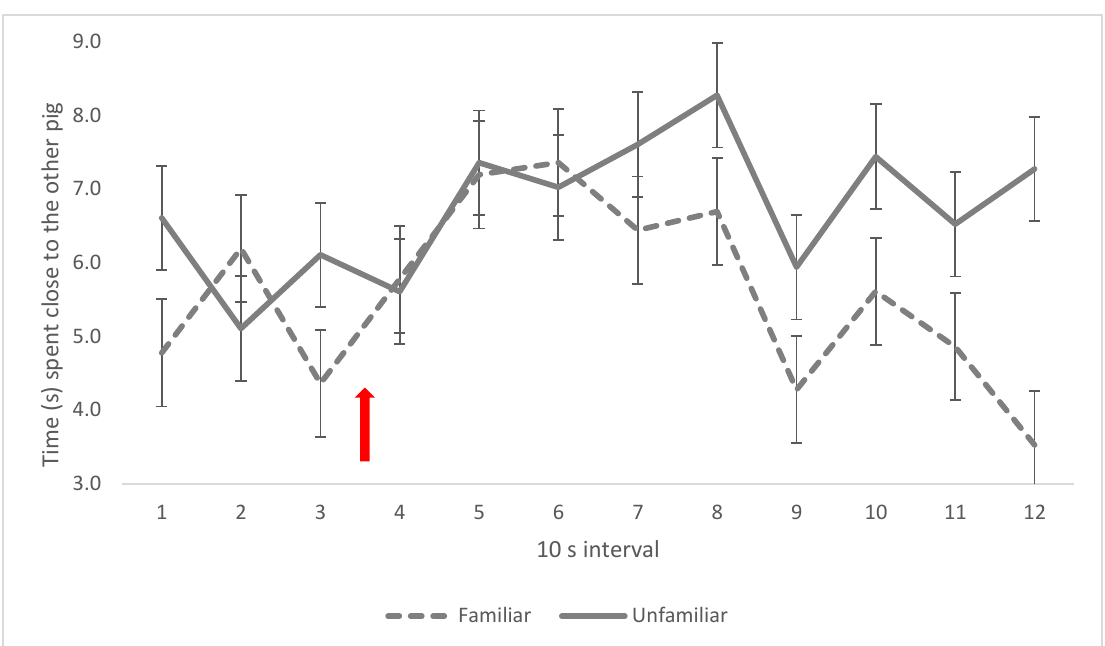
Figure 6. Pig closeness in the social treatments, expressed as mean time (s) spent sharing a floor square with at least one hoof each per 10 s interval . Red arrow indicates time of foam start. Values given are LSM ± SE. Lack of overlap of SE error bars indicates significant pairwise difference ( p < 0.05) between treatments or over time between intervals. Overall p -value for the interaction: p = 0.019.